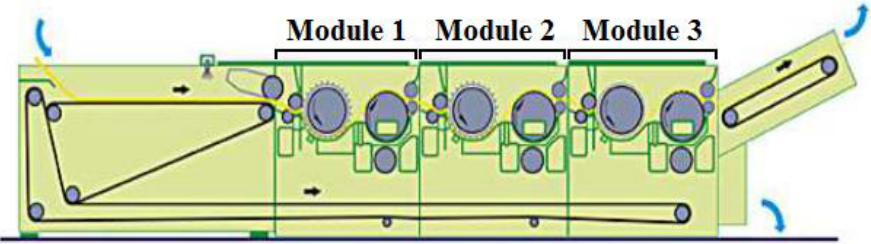
Figure 1. Laroche Cadette 1000 “all fibre” extraction device used in this study (from Laroche Cadette company website, https://laroche.fr, accessed on 21 June 2021).